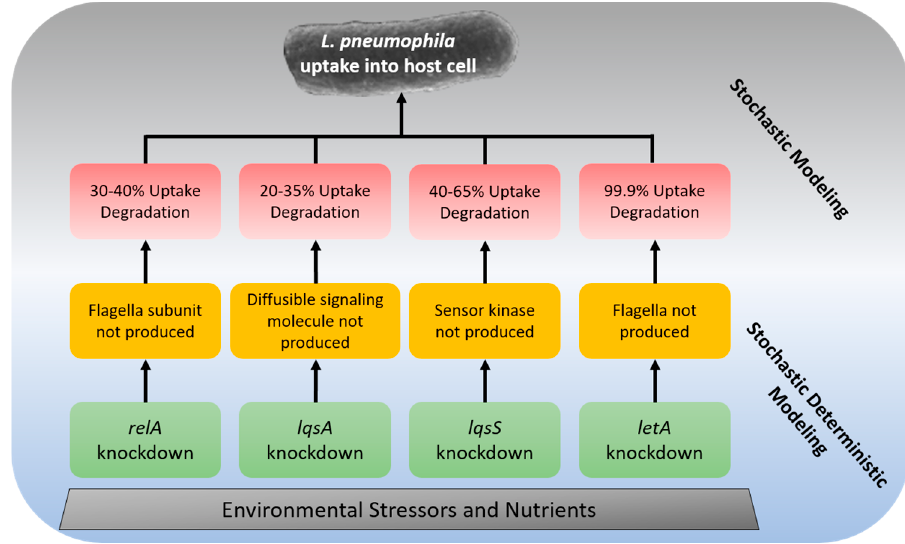
Figure 1. Postulated framework to computationally model the uptake of L. pneumophila into host cells.